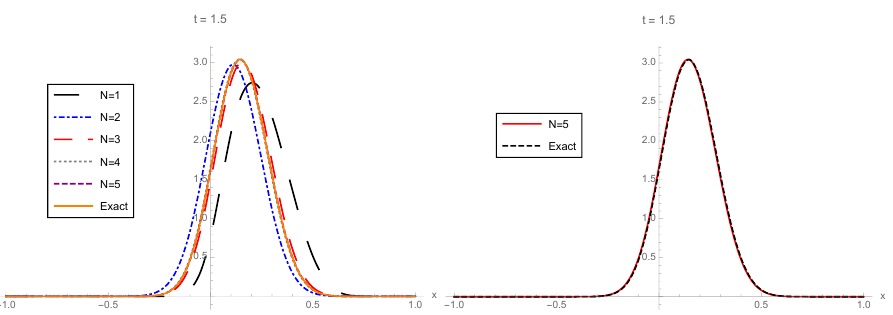
( x , t ) , of the truncated solution SP, X N ( t ) , to the random IVP (27) taking as Figure 2. Left : 1-PDF, f N 1 the order of truncation N ∈ { 1,2,3,4,5 } and the corresponding 1-PDF, f 1 ( x , t ) , of the exact solution ( x ,1.5 ) , with N = 5, is plotted together with SP at t = 1.5. Right : To facilitate the comparison, f N 1 f 1 ( x ,1.5 ) . Example 1.